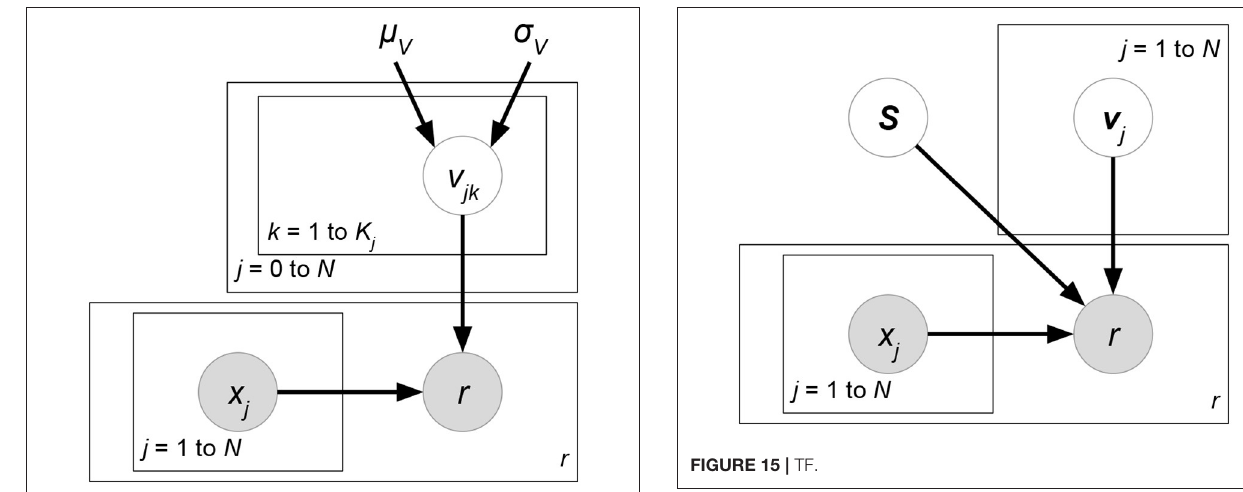
FIGURE 14 | v -approximate generalization.